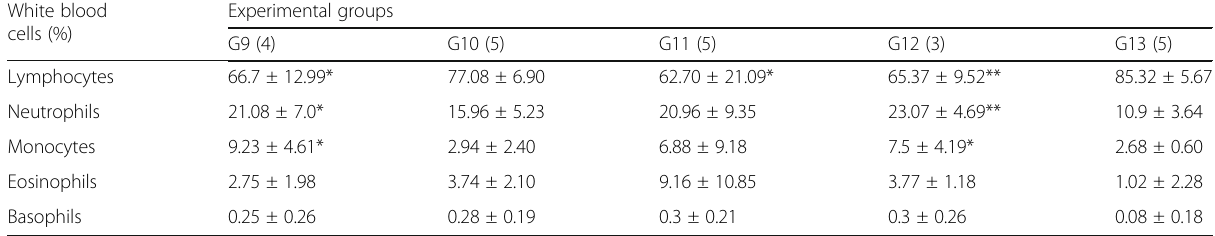
Table 2 Effect of ethanolic stem bark extract of C. swynnertonii on differential white blood cells in mice White blood cells